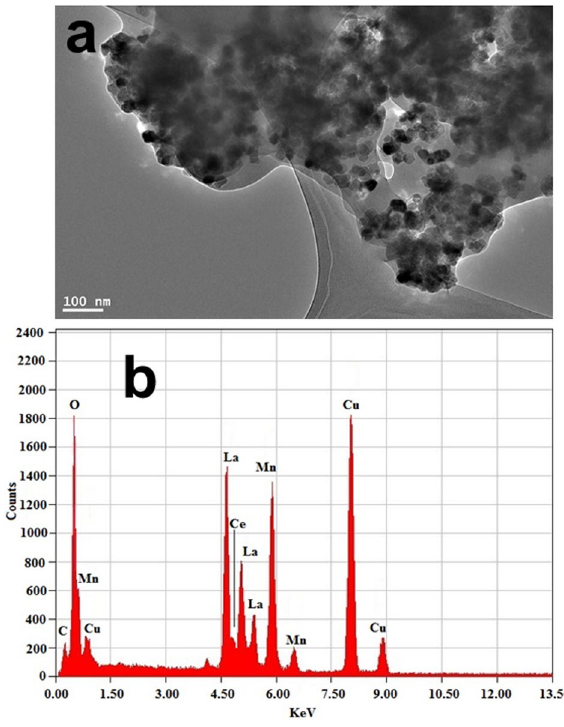
Figure 2. ( a ) TEM image and ( b ) EDX analysis of LaMnO 3 , nanoparticles.